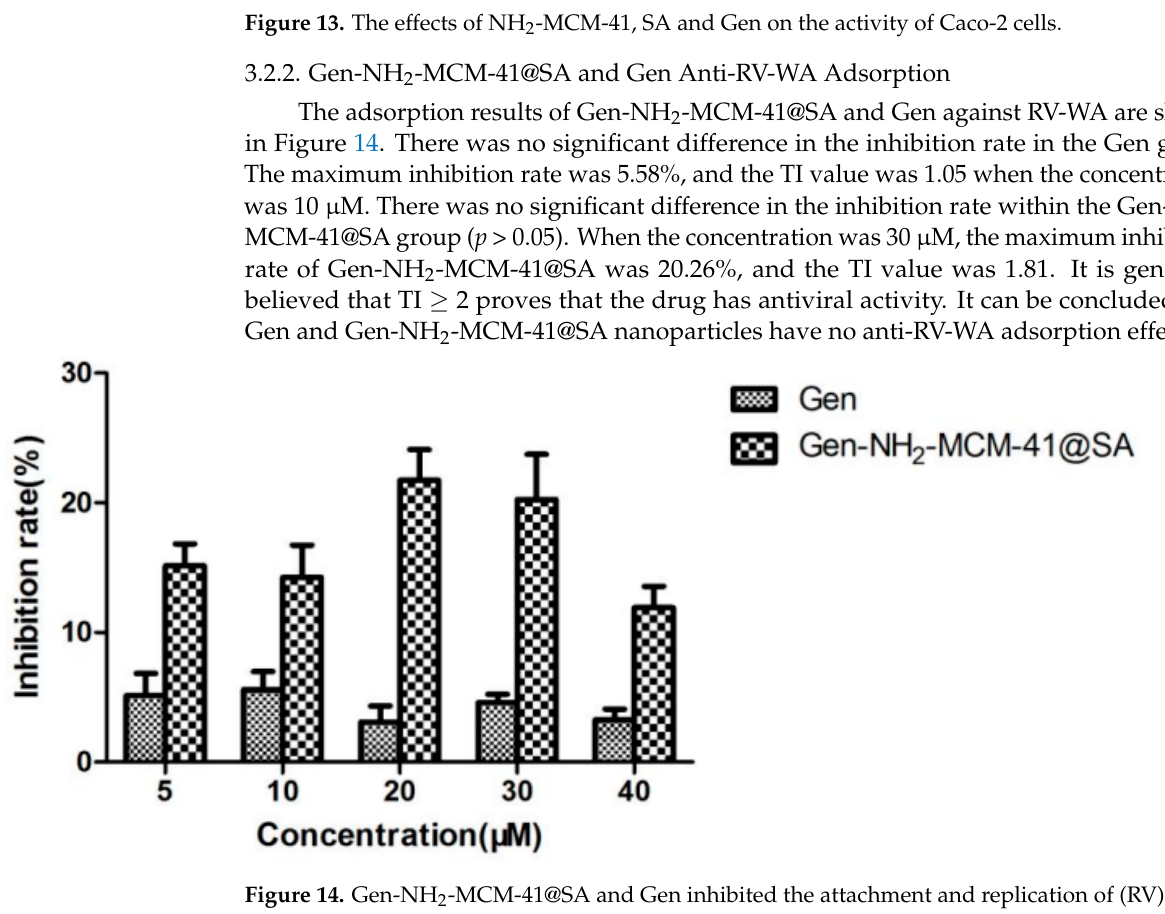
Figure 13. The effects of NH 2 -MCM-41, SA and Gen on the activity of Caco-2 cells.